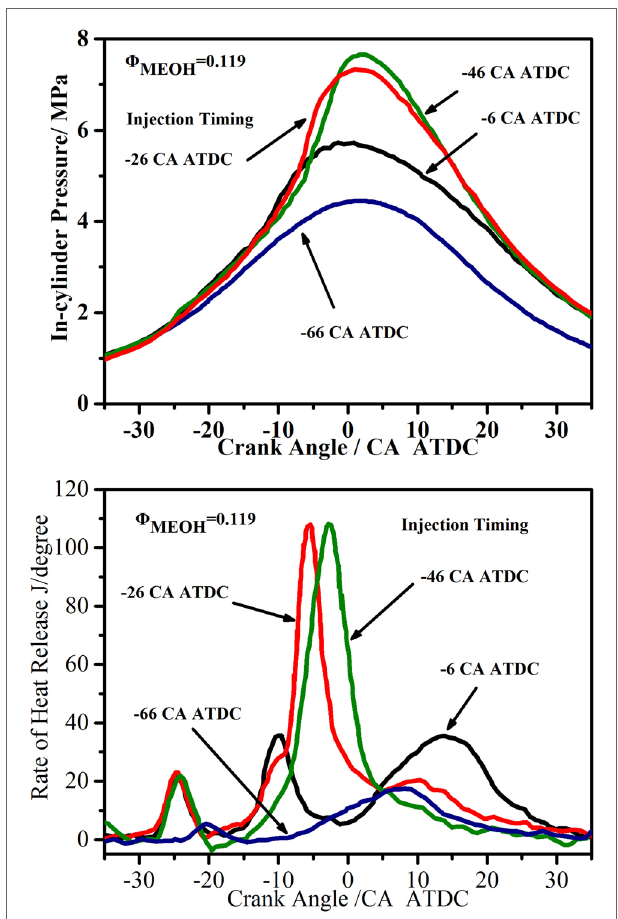
FiGURe 6 | effects of injection timing on (A) in-cylinder pressure and (B) rate of heat release in thermal-atmosphere controlled combustion mode